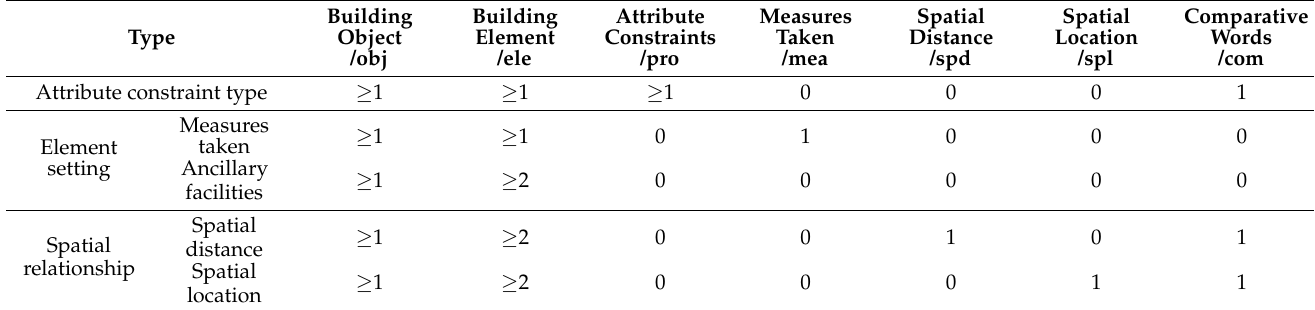
Table 2. Judgment basis for knowledge types of safety regulations.